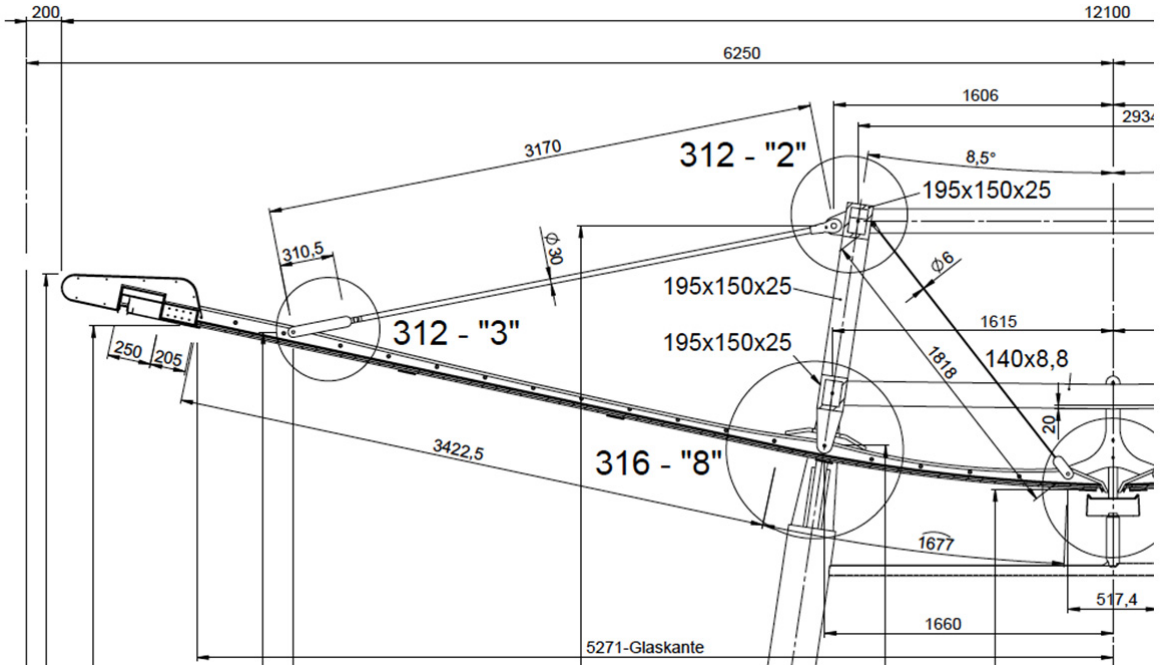
Fig. 7 Cross section of installed regular steel-glass